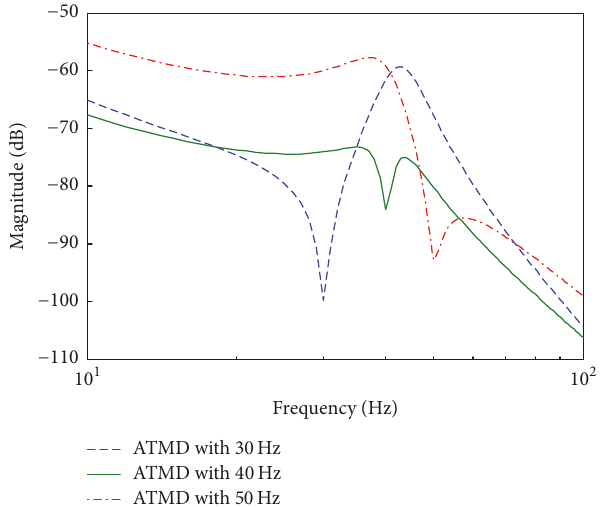
Figure 10: Power of the ATMDs with different natural frequencies.